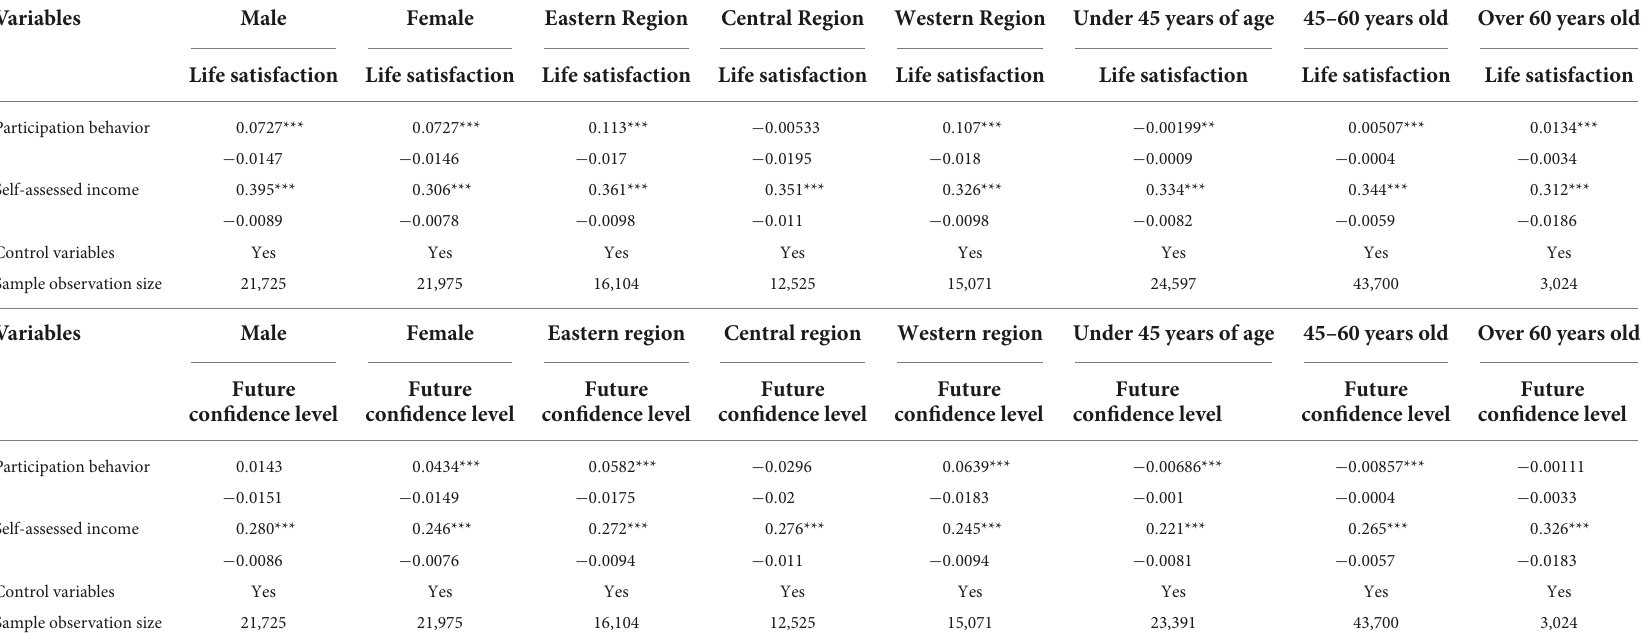
TABLE 6 Heterogeneous effects of social insurance participation on farmers’ perception of subjective well-being: sub-sample regression results. Variables